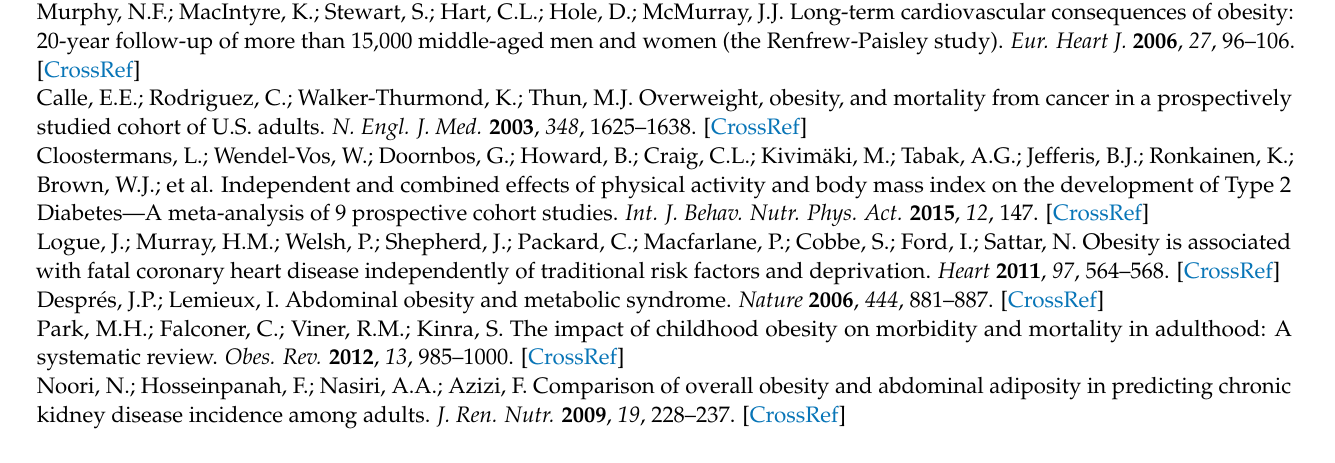
Korea, Table S1: Total number of participants by sex and sociodemographic factors: the KNHANES I–VII; Table S2: Result of the segmented regression models predicting overall (BMI ≥ 25 kg/m 2 ) and abdominal obesity prevalence by sex; Table S3: Mean BMI and WC by demographic and socioeconomic factors in men and women: the KNHANES I–VII; Table S4: The prevalence, odds ratios (ORs) and 95% confidence intervals (CIs) of overall and abdominal obesity by region and occupation type in women: the KNHANES I–VII; Table S5: Beta coefficients ( β ) and 95% confidence interval (CI) for the associations of socioeconomic factors (income, education, region, occupation) with mean BMI and WC in men: the KNHANES I–VII; Table S6: Beta coefficients ( β ) and 95% confidence interval (CI) for the associations of socioeconomic factors (income, education, region, occupation) with mean BMI and WC in women: the KNHANES